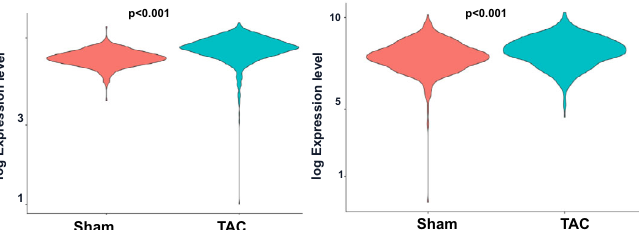
Fig. 6 Increased exosomal and hypoxic scores in cardiomyocyte populations upon hypertrophic remodeling. Representative violin plots showing expression levels for the cardiac chaperone Cryab and exosomal makers Cd9, Cd81 and Cd63 in clusters CM1-CM4 from sham (pink) and TAC (orange) hearts of CH ( a ) and FH ( b ). Hypoxia ( c ) and exosomal scores ( d ) in sham and TAC cardiomyocytes in CH and